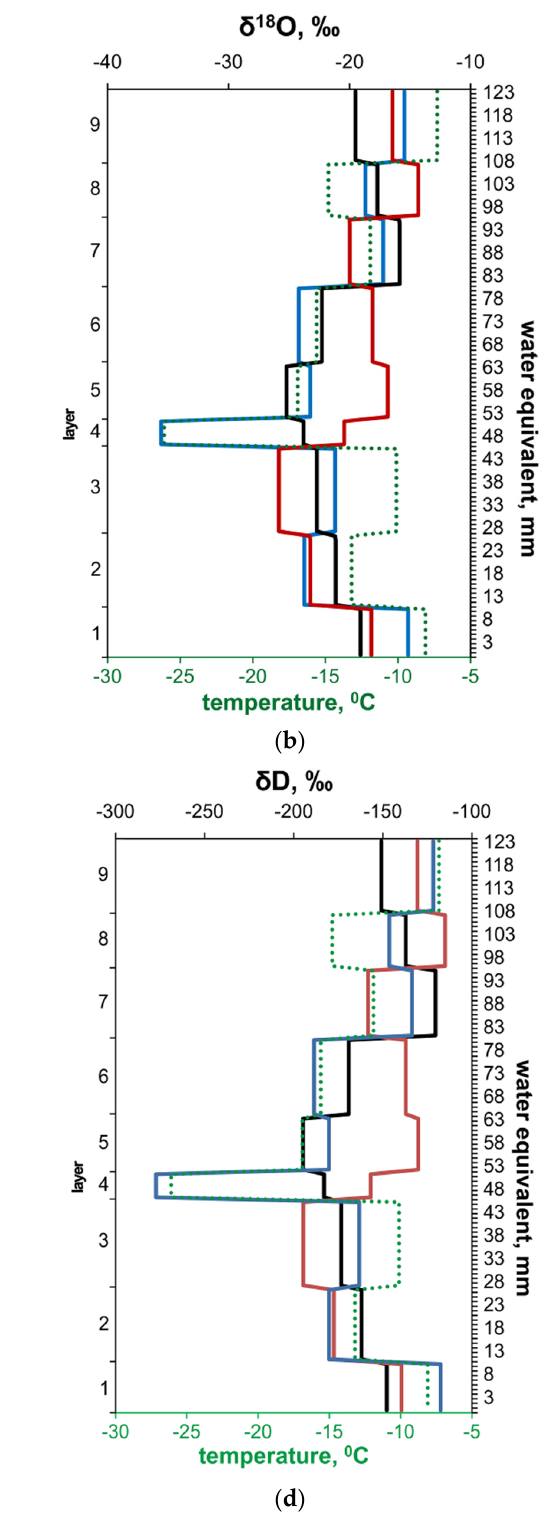
Figure 3. Comparison of changes in the isotopic composition ( δ 18 O and δ D) of snowfalls during their storage in the snowpack layers (experiment No. 2, winter period 2020–2021). Black—layers of snow in experimental site I; red—layers of snow in experimental site II; blue—precipitation-weighted mean of the event-based snowfalls; green dot line—mean of the daily average air temperature (( a , c )—snowpack in the barrel; ( b , d )—snowpack on the soil).